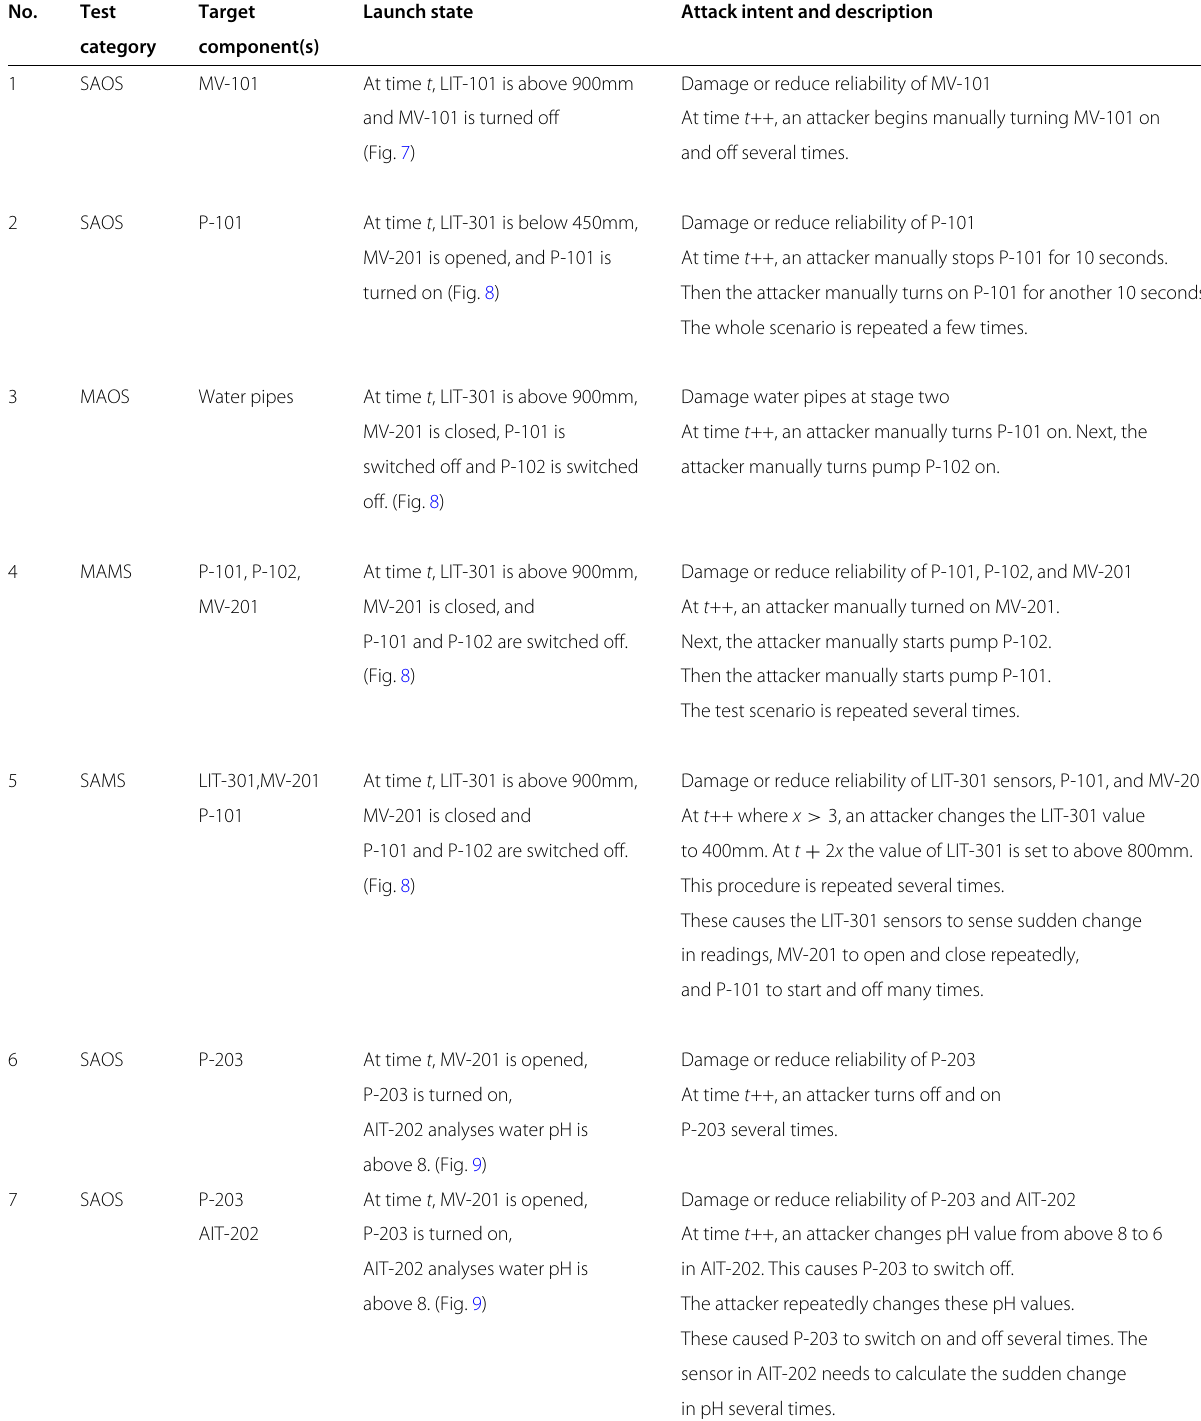
Table 11 Attacks launched on SWaT to test our invariant checkers